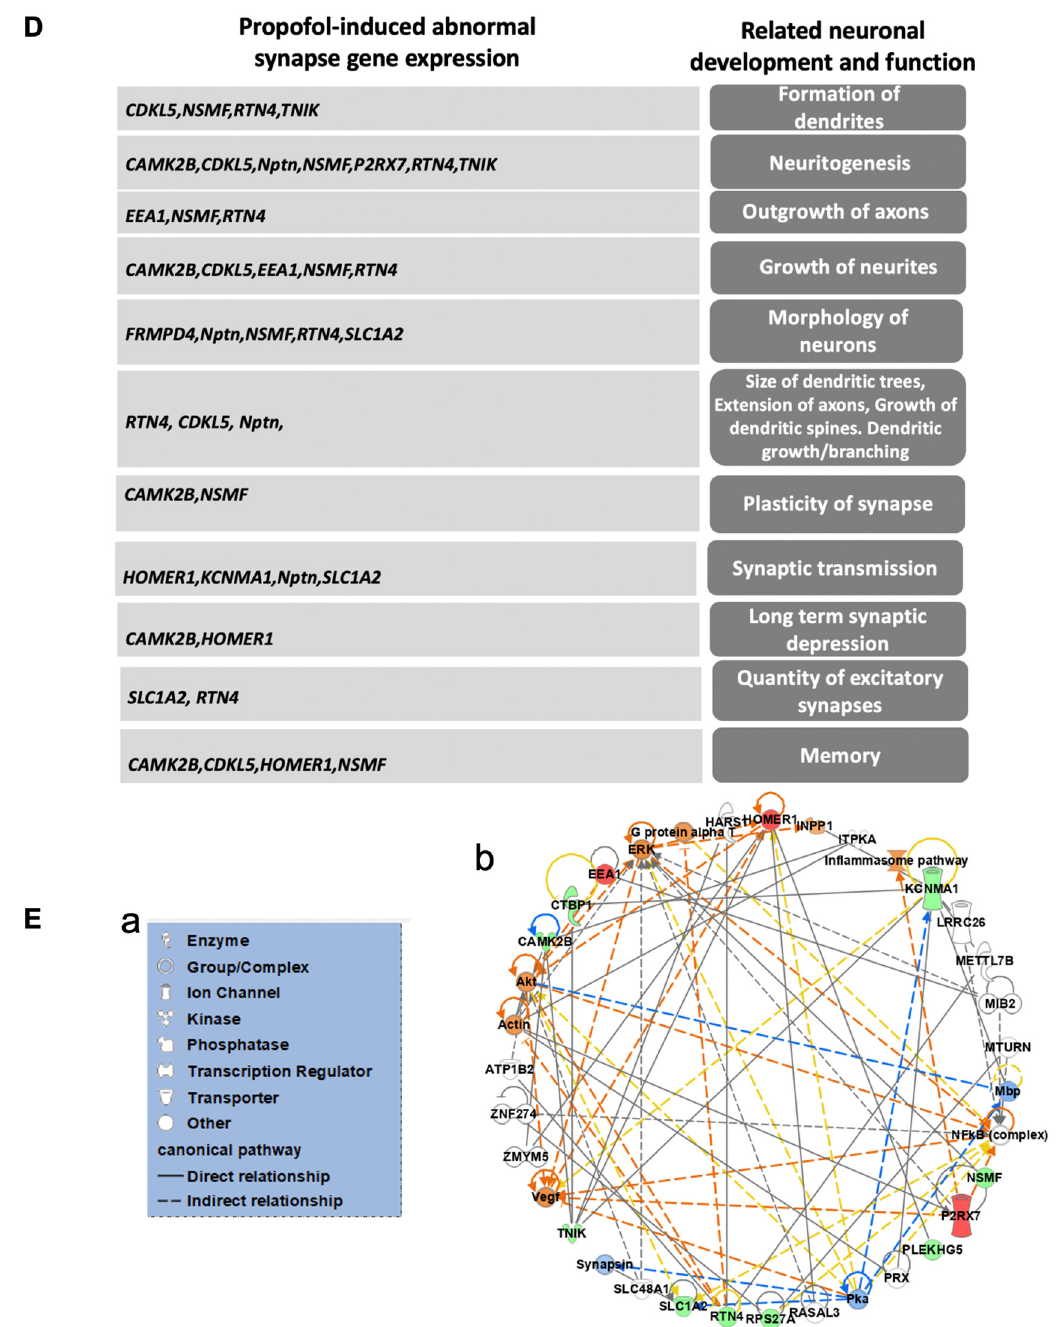
Figure 6. Propofol − induced dysregulated synaptic genes in P60 mouse hippocampi. ( A ) Bioinfor- matic analysis of 317 propofol − induced differentially expressed genes to define the dysregulated synaptic genes through the SynGO database. The analysis showed that 23 − propofol − induced dys- regulated genes were synaptic genes. The sunburst plot depicts the synapse location (cell component for presynapse, postsynapse, synaptic cleft, extra-synaptic space, or synaptic membranes) and functions (biological process related to metabolism, transport, synapse organization, synaptic signaling, presynapse, and postsynapse) of these 23 synaptic genes. Different color represents the gene counts per term of each location ( a ) or each function of synapse ( b ). The information of the synapse location and function of these 23 genes were described in Table 1 in detail. ( B ) The horizontal column chart depicts the gene count per synaptic cellular component shown in ( A ). ( C ) Gene ontology (GO) analysis of molecular functions of both downregulated and upregulated synaptic genes. ( D ) IPA bioinformatic analysis of function associated with propofol-induced dysregulated